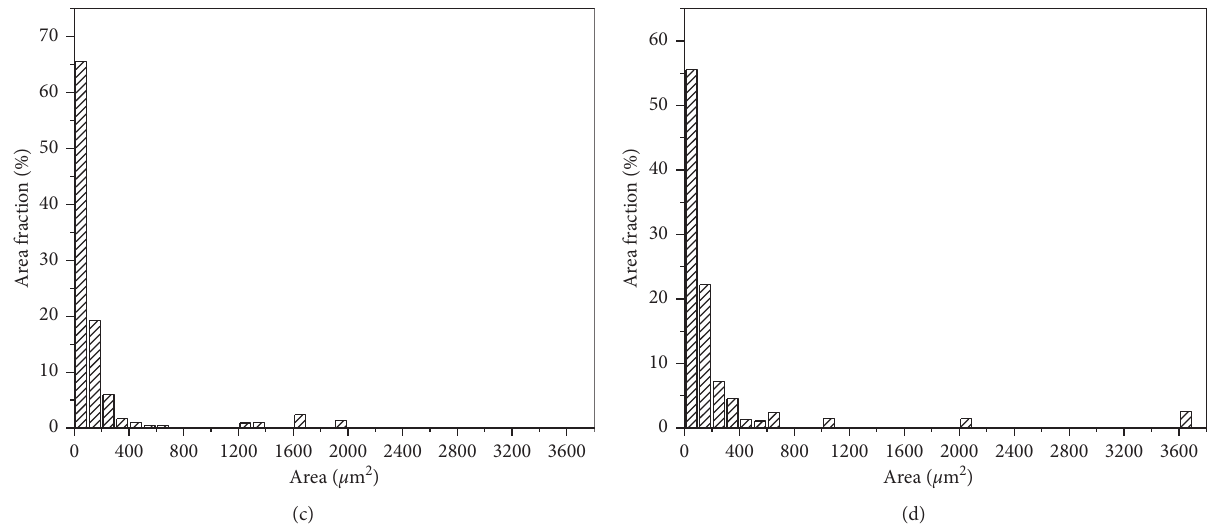
Figure 10: Grain area distributions of the alloys rolled at different temperatures which were determined from EBSD images: (a) 300 ° C, (b) 350 ° C, (c) 400 ° C, and (d) 450 ° C.